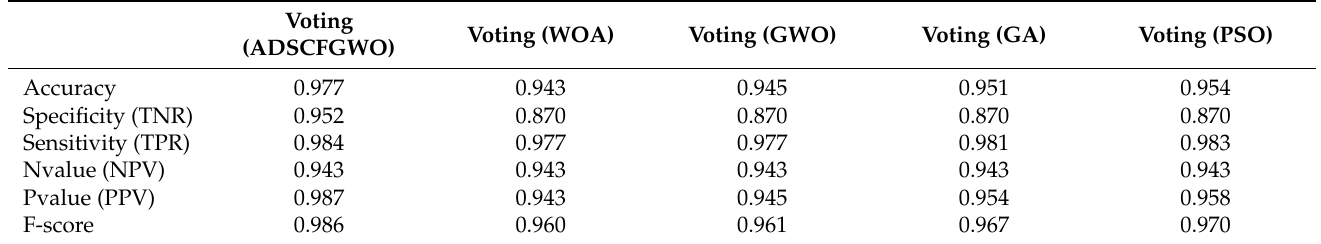
Table 9. Evaluation of the results achieved by optimizing the proposed voting classifier using the proposed optimization method and three other optimizers.